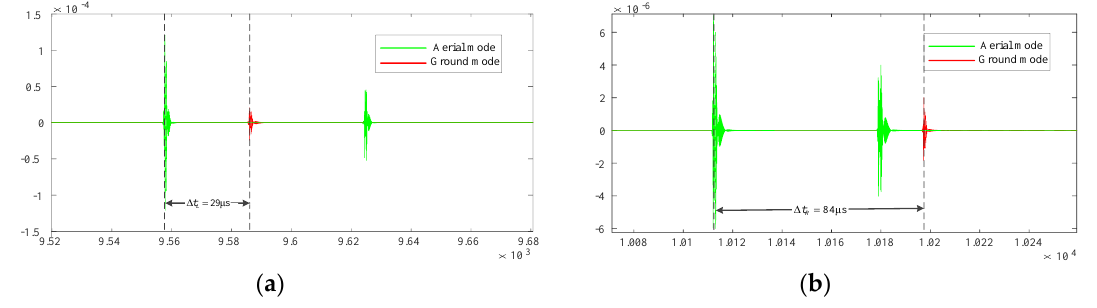
Figure 13. Time difference at terminals. ( a ) Terminal L ( b ) Terminal R.